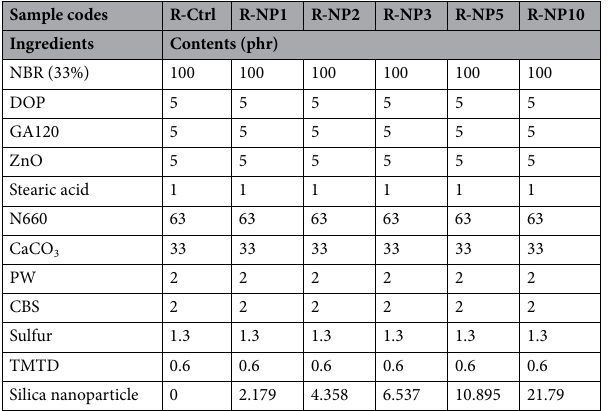
Figure 1. Interfacial interactions of VTES grafted nano silica to rubber matrix; ( a ) agglomeration of pure nano silica in NBR matrix, ( b ) dispersion of silanized nano silica in NBR matrix and ( c ) interfacial interfacial interactions between silanized nano silica and NBR. Sample